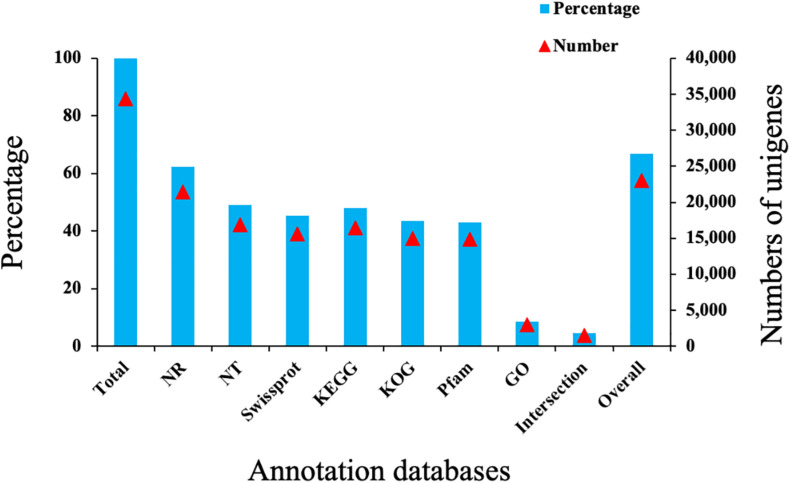
Summary of the unigene annotations in the Arma chinensis antennal transcriptome. Total, all annotation unigenes; NR, non-redundant protein; NT, nucleotide sequences; Swiss-prot, a manually annotated and reviewed protein sequence database; KEGG, Kyoto Encyclopedia of Genes and Genomes; KOG, euKaryotic Ortholog Groups; Pfam, protein family; GO, Gene Ontology; Intersection, unigenes annotated in all databases; Overall, unigenes annotated in at least one of the databases.